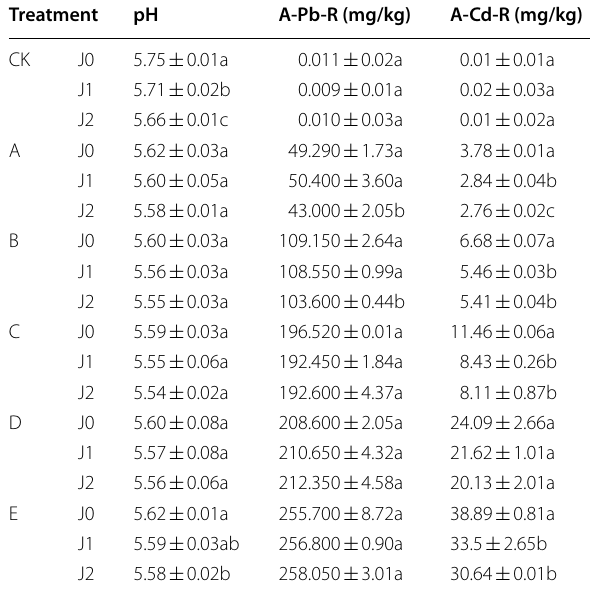
Table 2 Effective state Pb and Cd concentrations and pH